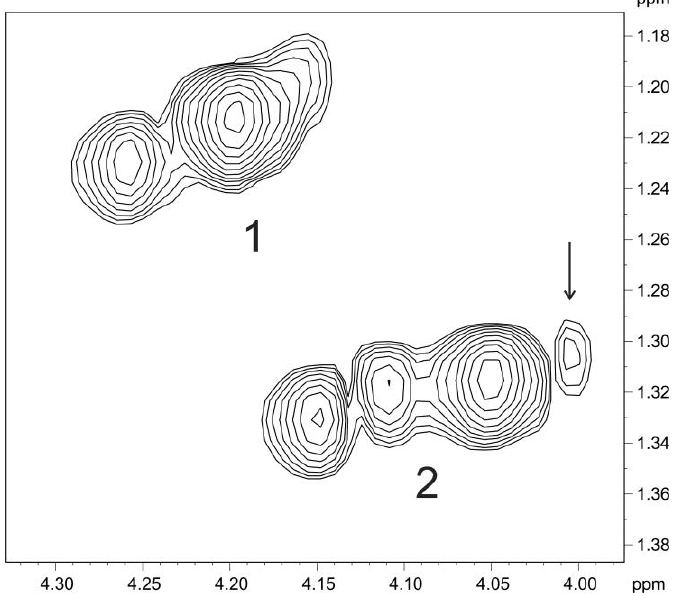
Figure 10. Part of a 600-MHz 2D 1 H, 1 H COSY spectrum of the O-polysaccharide displaying 6dTal H-5/H-6 correlations. Two series of cross-peaks (1 and 2) were assigned to the O-acetylated forms of 6dTal that do, and do not, include the 4- O -acetyl group, respectively. The arrow points to the H-5/H-6 cross-peak of a nonacetylated 6dTal residue.